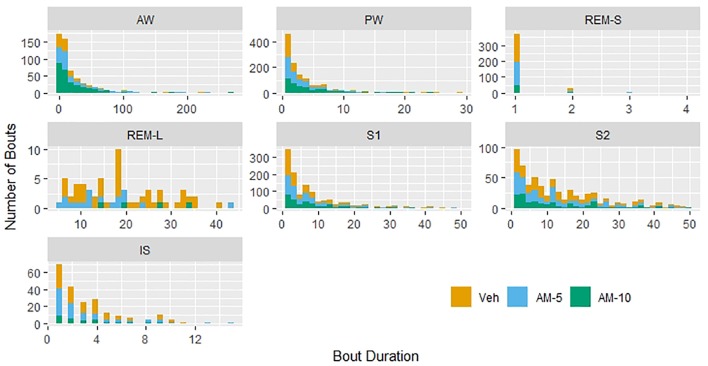
Histograms of bout durations of each vigilance stage. The Y axis shows the total counts of bouts in units of 4-s epochs during the 3-h-long observation period. The distributions of bout durations in rapid eye movement sleep (REMS) have two distinct components: a very short and relatively frequent bout, referred as “short REMS bout” (REMS-S) and the much longer and less frequent “long REMS bout” (REMS-L).